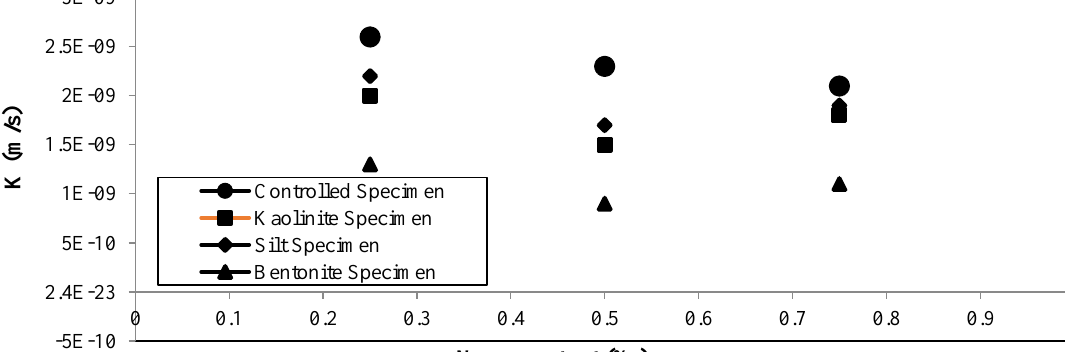
Fig. 12. Permeability of the mixtures with different types of